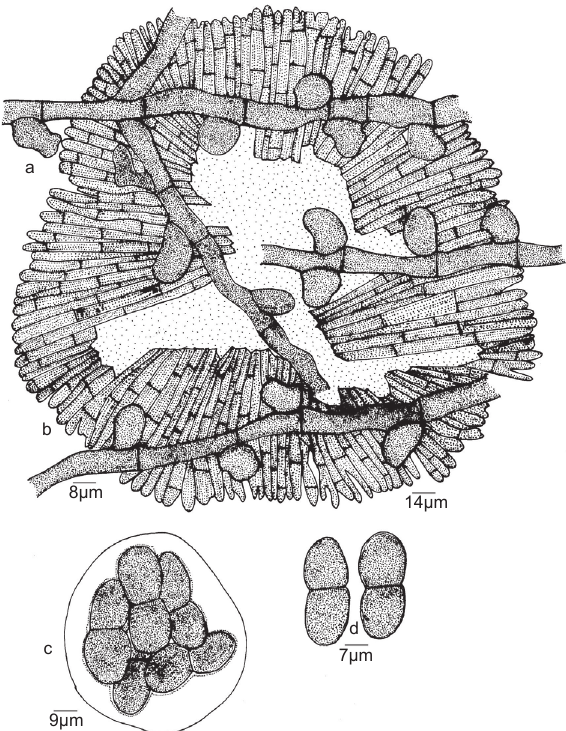
Figure 1. Asterina knemae attenuatae Hosag. a - Appressoriate mycelium; b - Thyriothecium; c - Ascus; d -